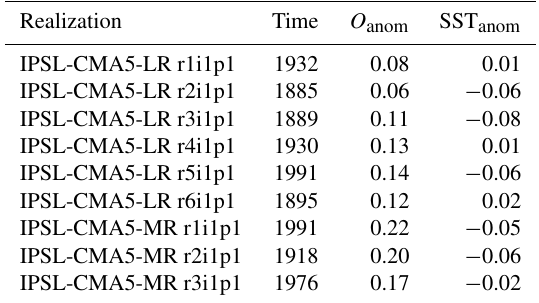
Table 6. Maximum decadal anomalies of ocean CO 2 uptake in the IPSL-CMA5 simulations (PgCyr − 1 per decade) and corresponding anomaly in tropical SST ( ◦ C) in the Nino3.4 region. The annual values of the ocean fluxes are filtered using the same smoothing as the one applied to AGR, based on the air-age distribution filter from Trudinger et al. (2003). The SST anomaly is calculated as the aver- age departure of the filtered SST data from a 30-year-long reference